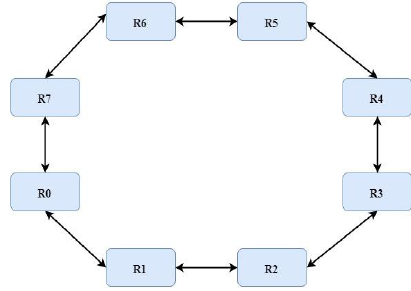
routing algorithm is implemented on a mesh